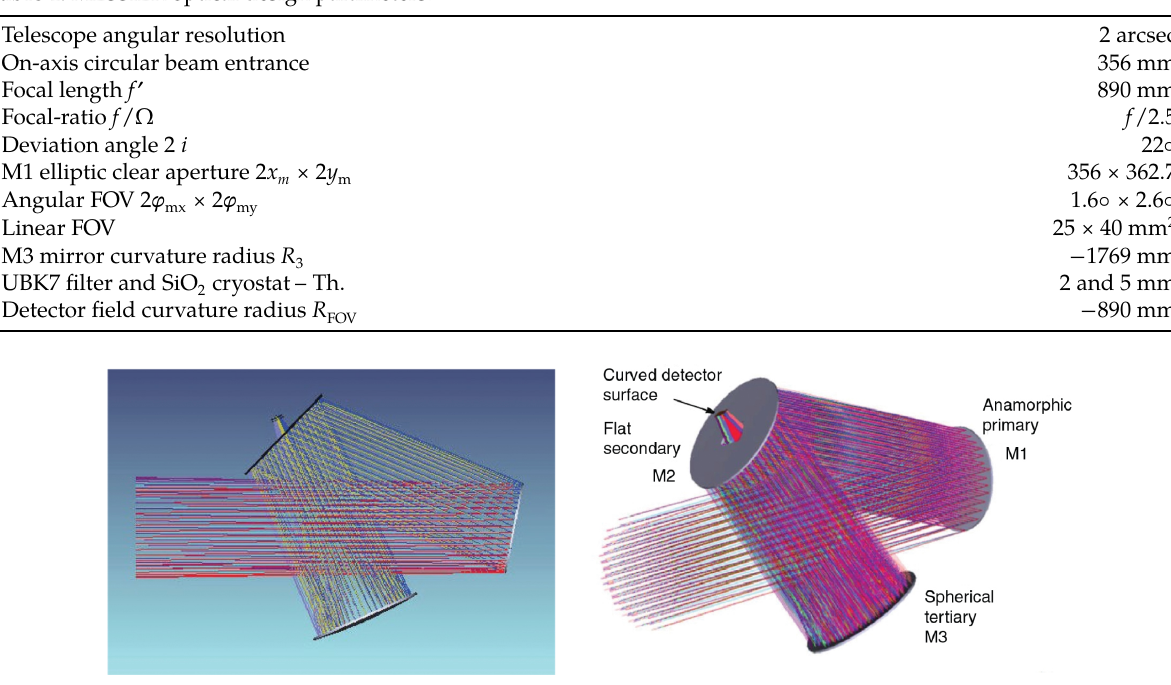
Figure 15: (Left) MESSIER layout reflective TMA in the symmetry plane. (Right) 3-D view of mirrors and